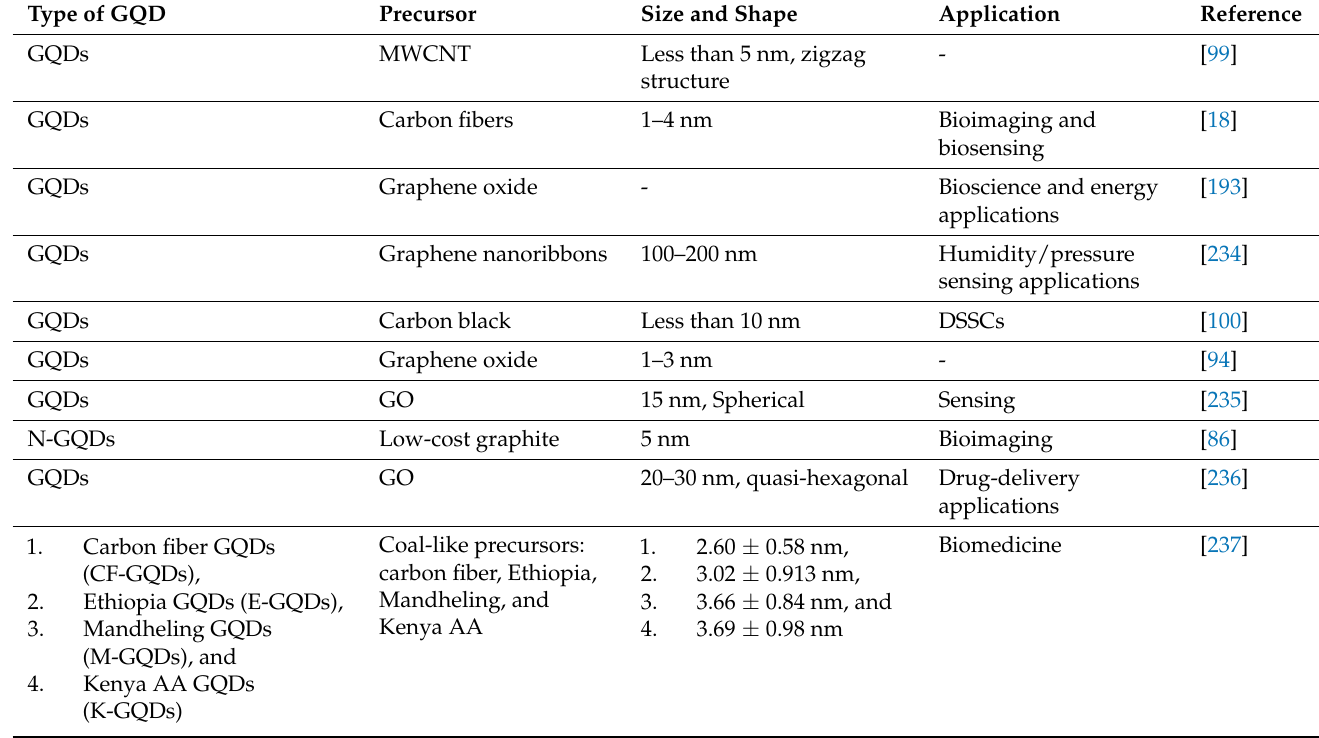
Table 7. The oxidative cleavage methods for the preparation of GQDs.